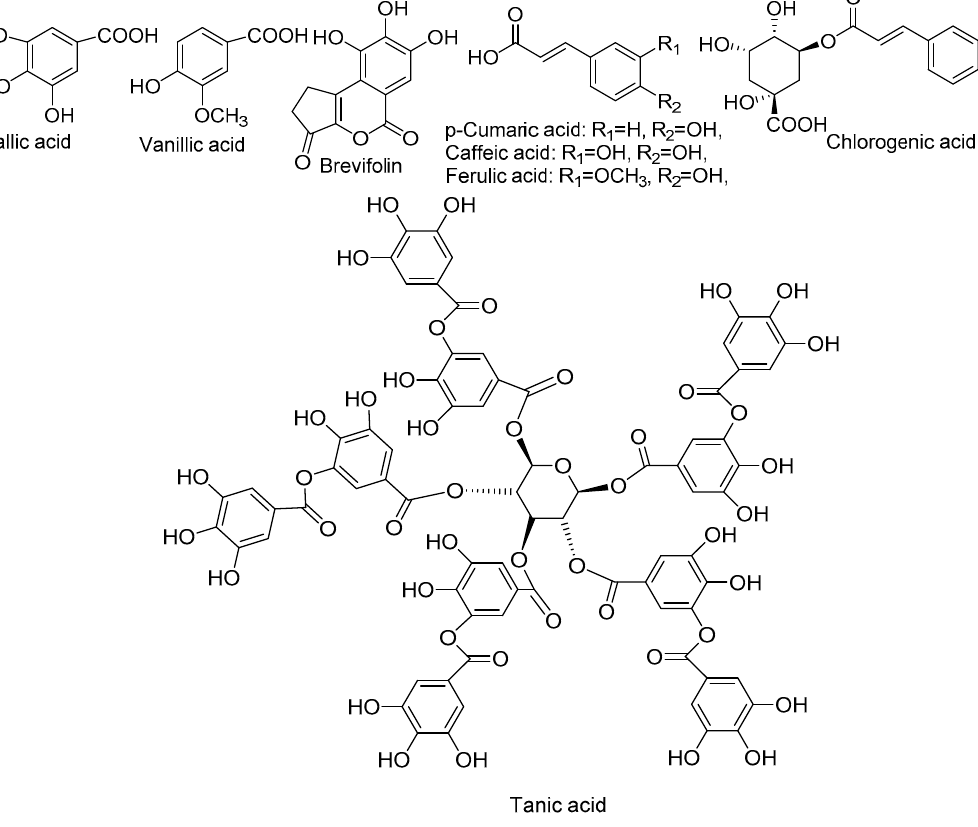
Figure 4. Structures of phenolic acids and derivatives.